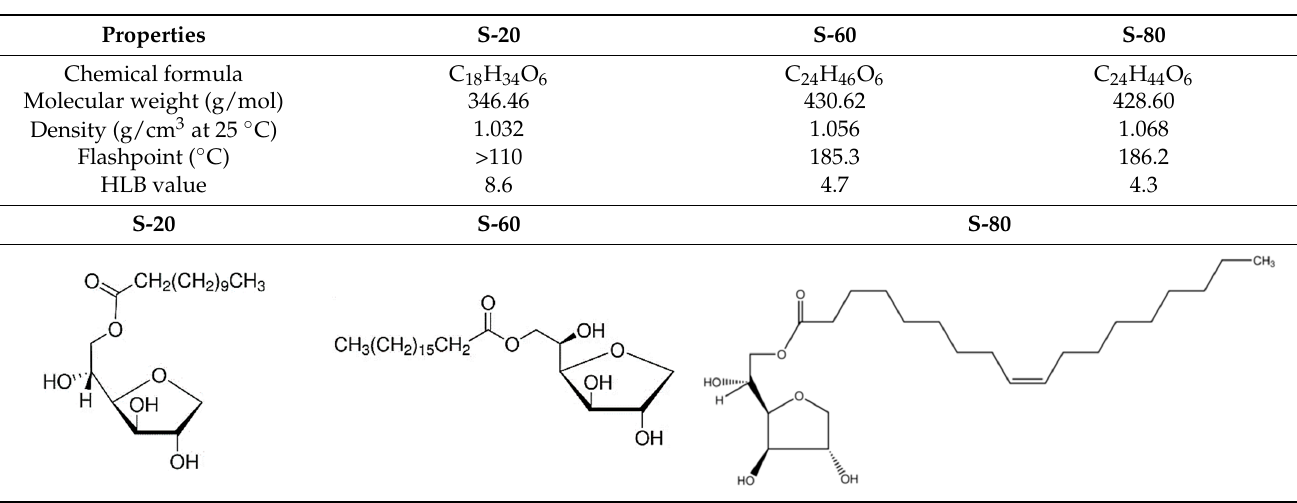
Table 3. Physical properties of the surfactants (open access webpage [32]).